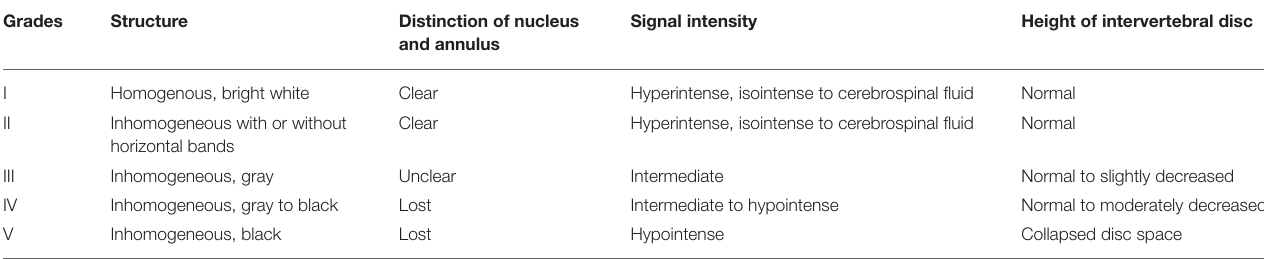
TABLE 2 | Summary of the Pfirrmann grading system for evaluation of disk degeneration. Grades